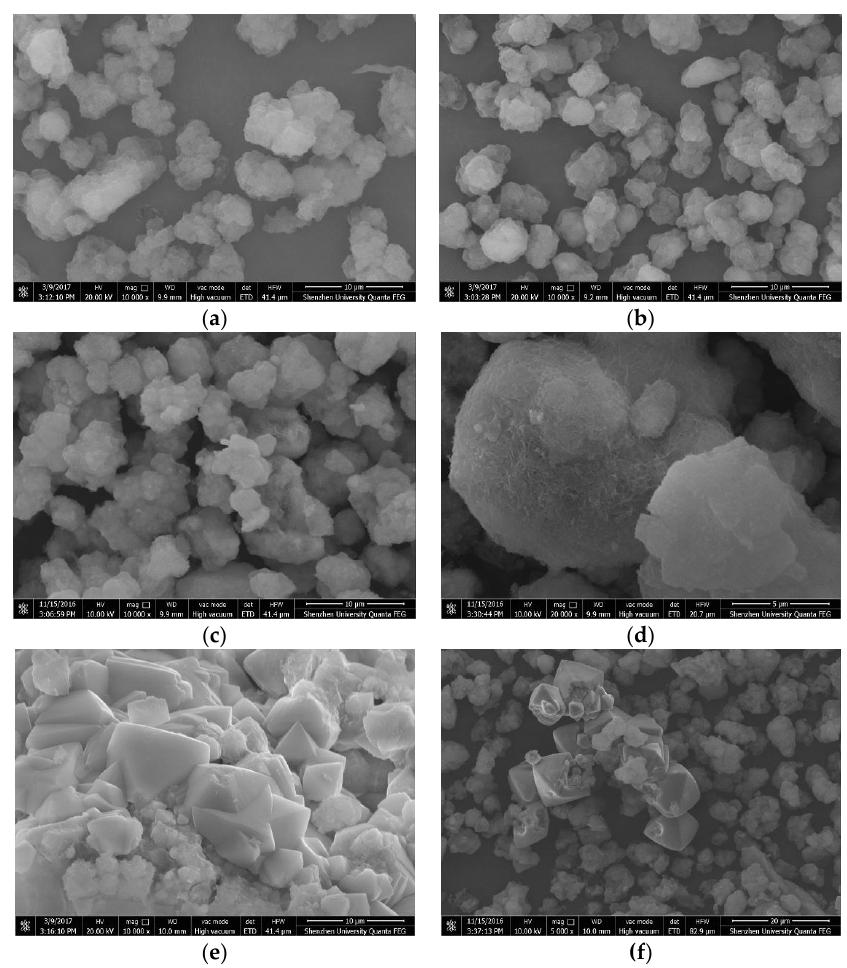
Figure 9. SEM images of the C-A-S-H system products. ( a ) CASH1.0_R_7d; ( b ) CASH1.0_60_7d; ( c